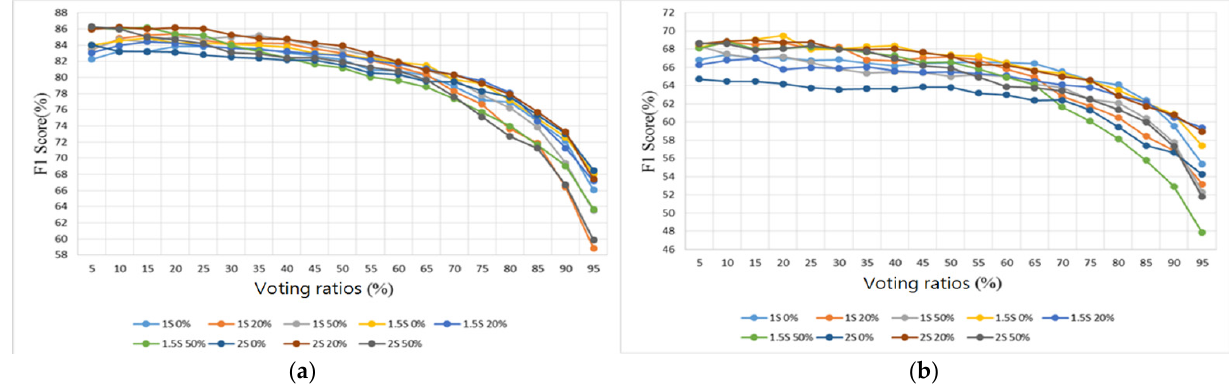
Figure 19. Heart sound classification results: F1 Score. ( a ) Testing samples. ( b ) Noisy samples. Table 4. Sizes of heart sound samples.